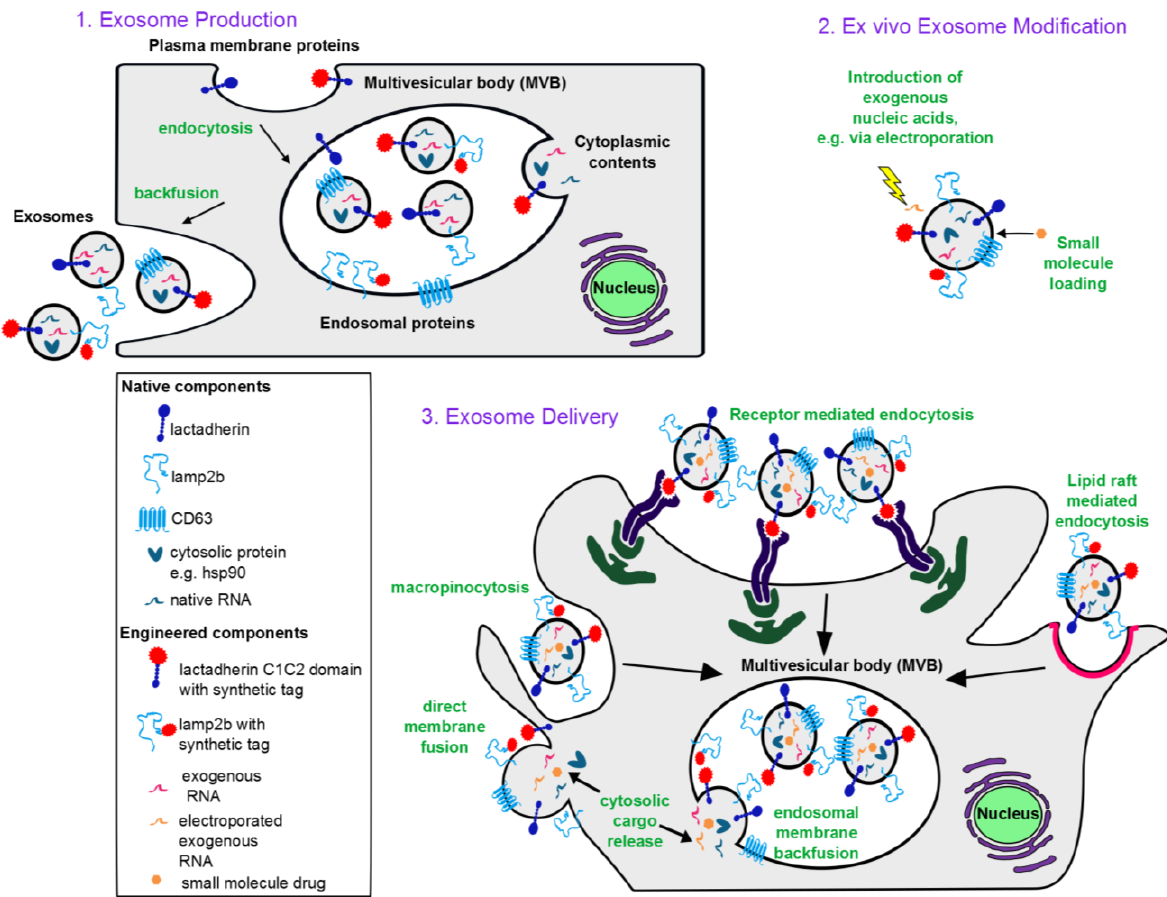
Figure 1. Conceptual overview of exosome-based therapeutics: (1) Exosome biogenesis . Exosomes incorporate membrane components from the plasma and endosomal membranes, cytoplasmic proteins and RNA. Plasma membrane proteins reach exosomes via endocytosis into the endosomes followed by invagination of the endosomal membrane to form intraluminal vesicles (intracellular precursors of exosomes). An endosome containing many such intraluminal vesicles is termed a multivesicular body. Upon invagination of the endosomal membrane, endosomal membrane proteins also get incorporated into intraluminal vesicles. During invagination, cytoplasmic contents including RNA and proteins are engulfed into the lumen of the intraluminal vesicles. Upon backfusion of the multivesicular body with the plasma membrane, intraluminal vesicles are released into the extracellular space and are then termed exosomes. (2) Ex vivo modification of exosomes . Nucleic acids can be introduced to the exosome lumen via electroporation, and lipophilic small molecules can be passively loaded. (3) Exosome delivery . Exosomes are internalized by recipient cells via macropinocytosis, receptor-mediated endocytosis, or lipid raft-mediated endocytosis, each of which results in exosomes being taken up into endosomes. Exosomal contents are then released into the cytoplasm via backfusion with the endosomal membrane. Alternatively, exosomes can fuse directly with the recipient cell plasma membrane to release exosomal contents into the cytoplasm. Mechanisms of internalization utilized depend on the ligands displayed on the exosome surface, the cell type from which the exosomes are derived, and the recipient cell